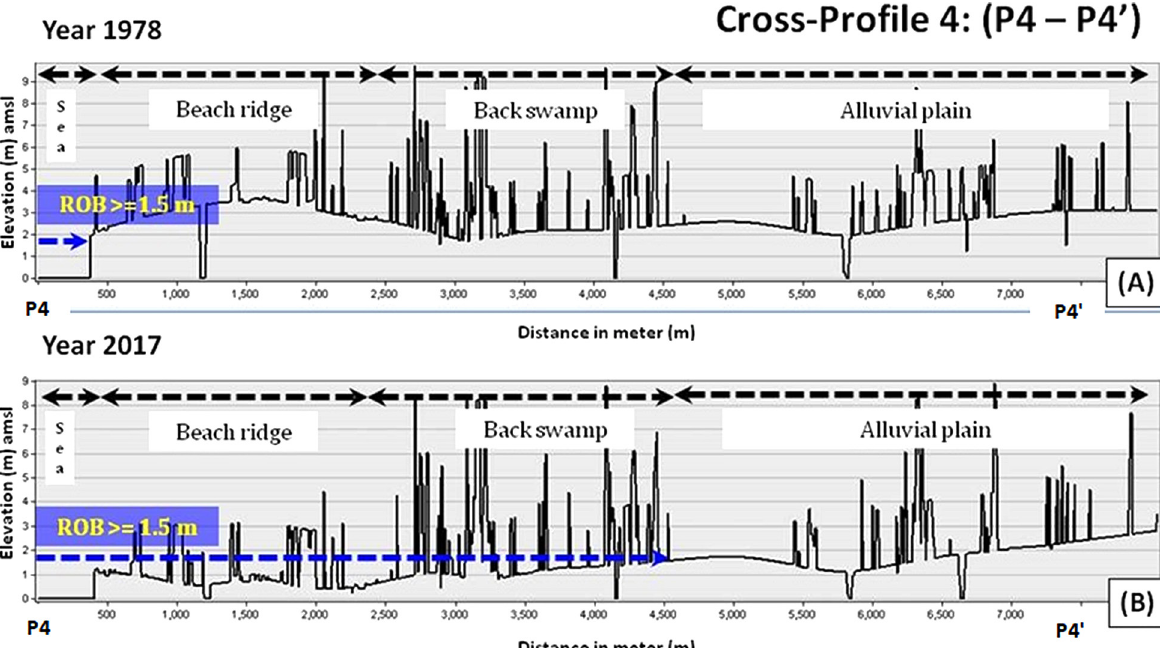
Fig. 11. Comparison results for morphological and topographic condition change from DEM modelling between 1978 and 2017 on cross-profile 4 (P4-P4’) and their implications for vertical tidal flood distribution in coastal landform areas. A. DEM cross-profile 4 in 1978; B. DEM cross-profile 4 in